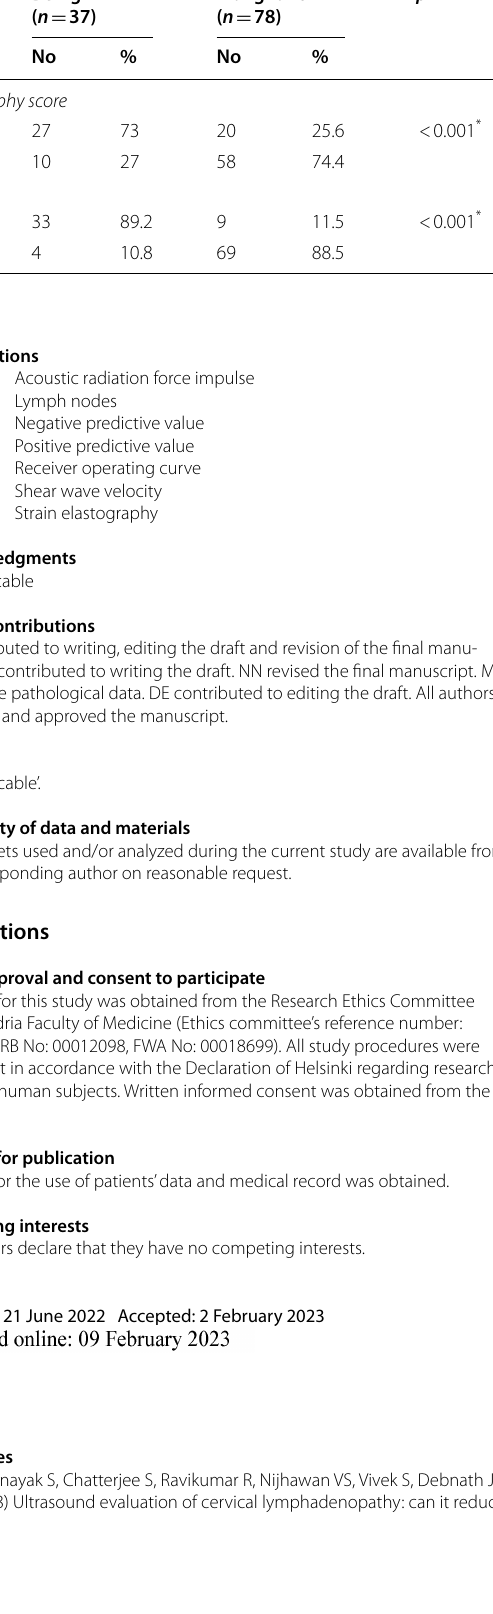
Table 4 Diagnostic performance of SE scales and ARFI at cut-off value of 2.7 m/sec Benign ( n =